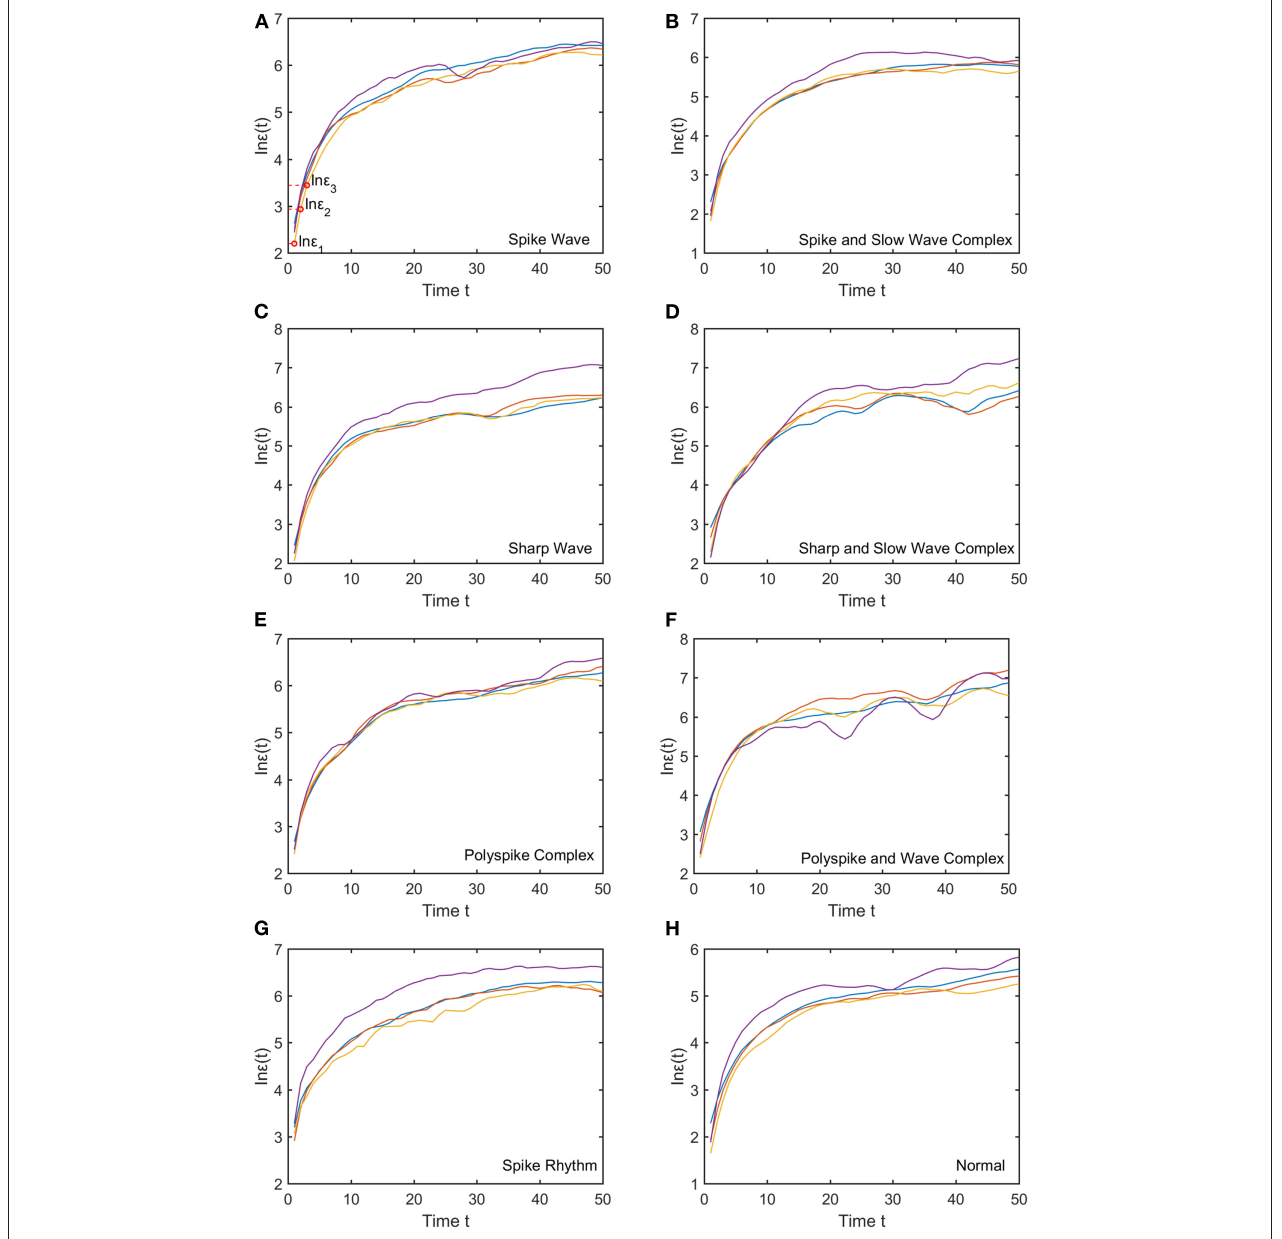
FIGURE 3 | Typical ln ε t vs. t curves for epileptiform discharges and normal EEG, where the four curves correspond to four different shells, with the diameter of the largest shell being 1 / √ 10 of the standard deviation of the EEG signal, and successive shells shrinking by a factor of 1 / √ 2. (A–H) illustrates the different between the seven types of epileptiform discharges (spike wave, spike and slow wave complex, sharp wave, sharp and slow wave complex, polyspike complex, polyspike and slow wave complex, spike rhythm discharges) and normal